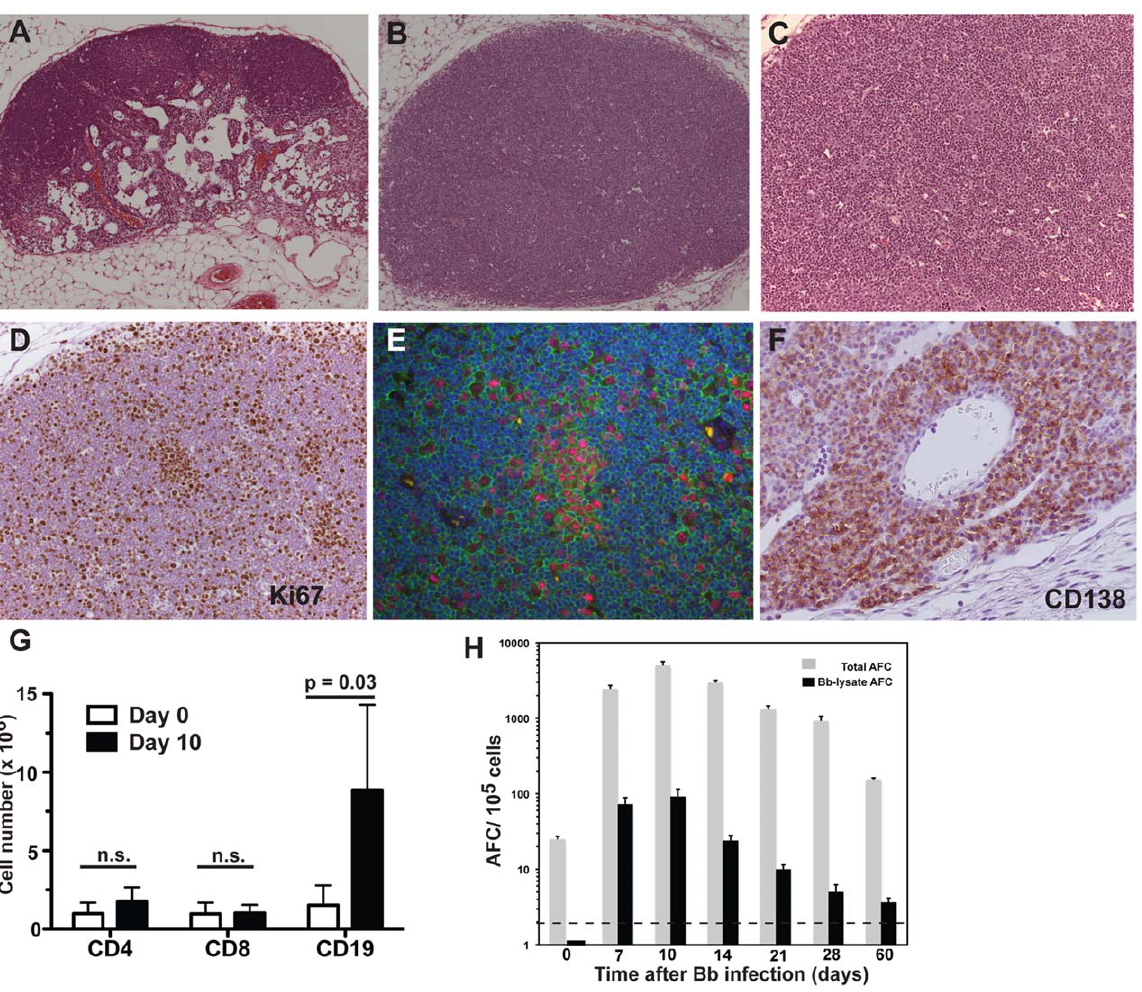
Figure 4. B.burgdorferi -induced lymphadenopathy is caused by a massive proliferation and differentiation of lymph node B cells. ( A–C ) H.E. staining of right inguinal lymph node from a C57BL/6 mouse ( A ) sham-infected or ( B ) infected by tissue-transplantation with host-adapted spirochetes 10 days prior. ( C ) Close-up image of (B). Note the complete lack of follicular and extrafollicular structure. ( D ) Immunohistochemistry on lymph nodes as in (B, C) reveals the presence of large numbers of Ki67 + proliferating cells in the lymph node cortex. ( E ) Three-color immunofluorescence identifies the Ki67 + (red) cells as B220 + (green) B cells. Blue color indicates nuclei as stained with DAPI. ( F ) Large numbers CD138 + plasma cells accumulate in the medullary cords of lymph nodes of infected mice as (in B/C) ( G ) Shown are mean cell numbers 6 SD from 4 C57BL/6 mice per time point of CD4, CD8 T cells and CD19 + B cells in inguinal lymph nodes before (white) and at day 10 (black) of infection. Data were calculated from flow cytometric evaluation of live cell frequencies and total live cell counts by hemocytometer with trypan blue exclusion. Results are from one of . 3 experiments performed that gave similar results. Statistical analysis was conducted by comparing results from each cell population using Student’s t test; n.s. not significant. ( H ) Shown are mean numbers of antibody-secreting cells (AFC) 6 SD for total (grey bars) and Borrelia-lysate (black bars)-specific antibodies in inguinal lymph nodes from 4 C57BL/6 mice per timepoint at the indicated times after infection with host-adapted B. burgdorferi . Horizontal bar indicates threshold levels of